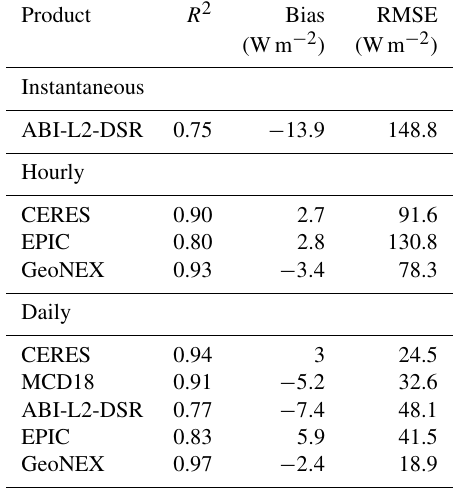
Table 2. Summary of the comparison results between the GeoNEX DSR product and other DSR